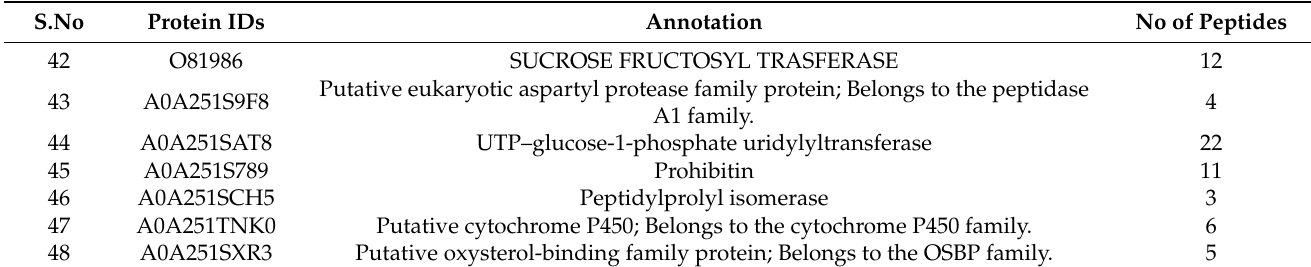
Figure 5. GO pathway categorization of the tuber proteome in the current study using PANTHER tool. Figure represents pathway categories to which 5 or more JA tuber gene hits were detected.